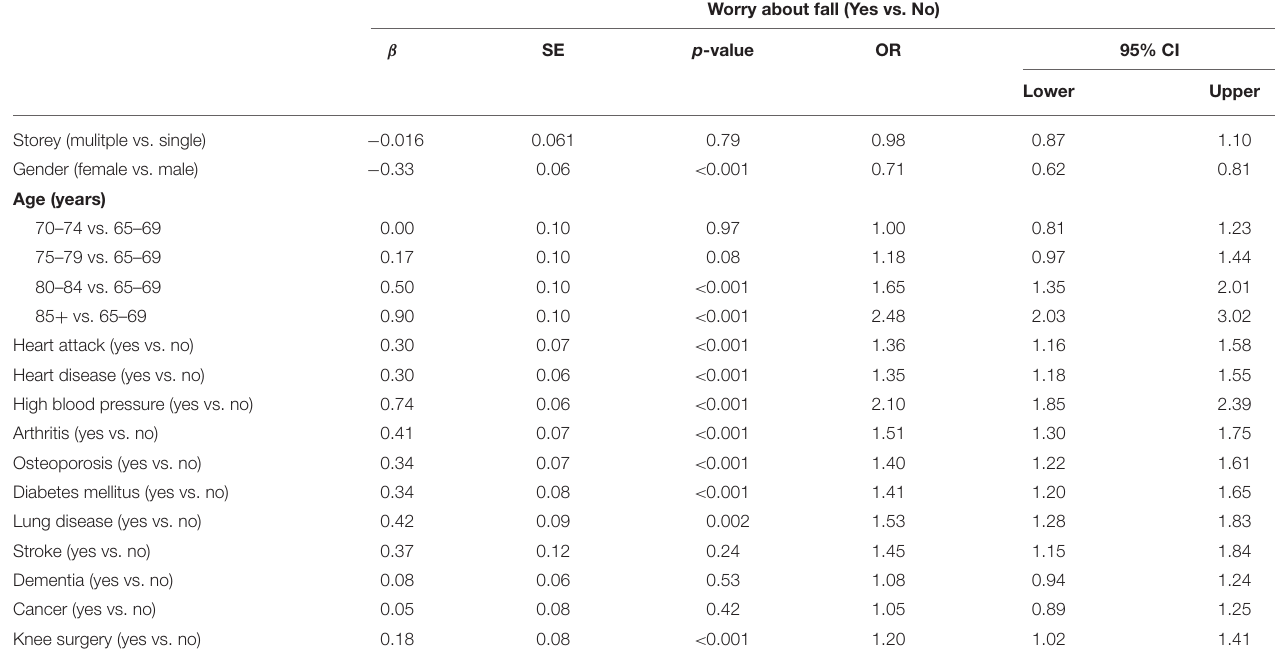
TABLE 4 | Multiple logistic regression model of worry about fall ( n = 6,142). Worry about fall (Yes vs. No) β SE p -value OR 95% CI Lower Upper Storey (mulitple vs. single) − 0.016 0.061 Gender (female vs. male)